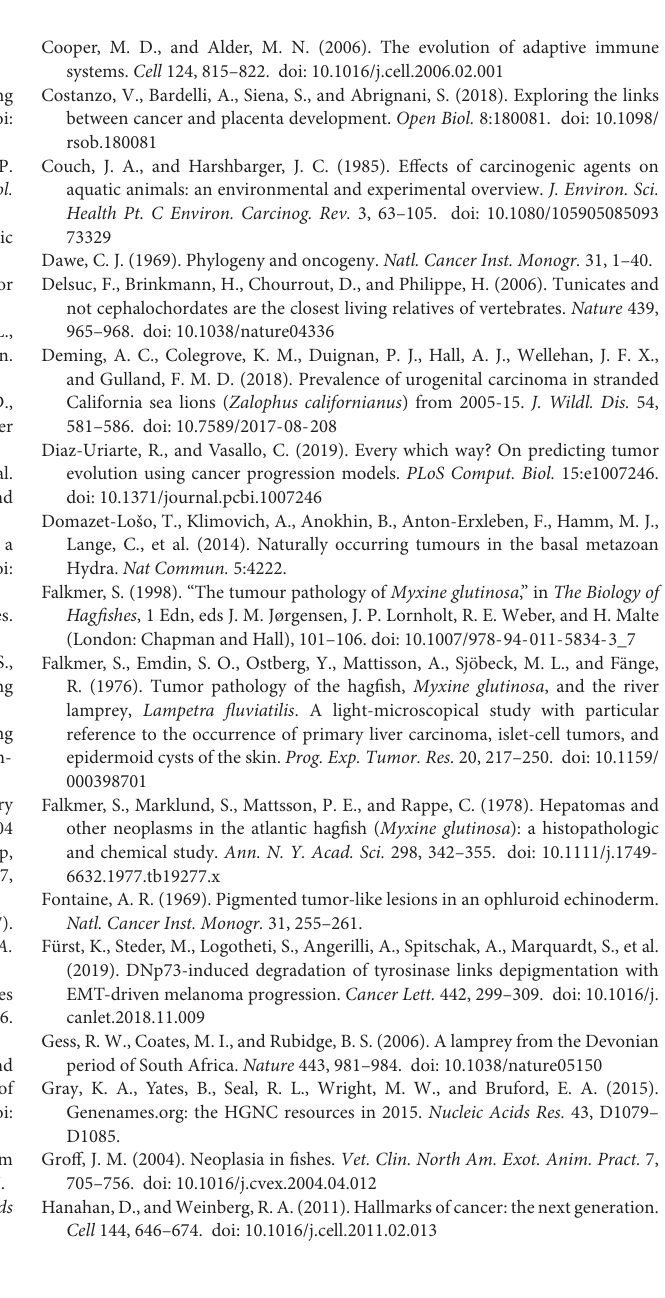
phenotypes to all developmental phenotypes affected by each gene knockout is also shown. Supplementary Table 3 | Associations of each JIG with genetic and epigenetic alterations in tumors, survival of PanCan patients, and expression in highly invasive or metastatic stages. Column annotations: CGC = included in the Cancer Gene Census list, Cancer driver = included among the cancer driver genes in PanCan, freqmut = included among the frequently mutated genes in PanCan, Methylation = differentially methylated JIGs in human tumors versus normal tissue, from DiseaseMeth database (hypo = hypomethylated, hyper = hypermethylated), CCLE = up- or down-regulated in highly-invasive vs. less-invasive human cells from the CCLE, Survival = impact on the survival prognosis of the patients from the PanCancer cohort based on Cox regression analysis, hsa_Metastases = up- or down-regulated in human metastatic vs. primary lesions (GSE21510, GSE2509, GSE25976, GSE43837, GSE468, GSE6919, GSE7929, GSE7930,